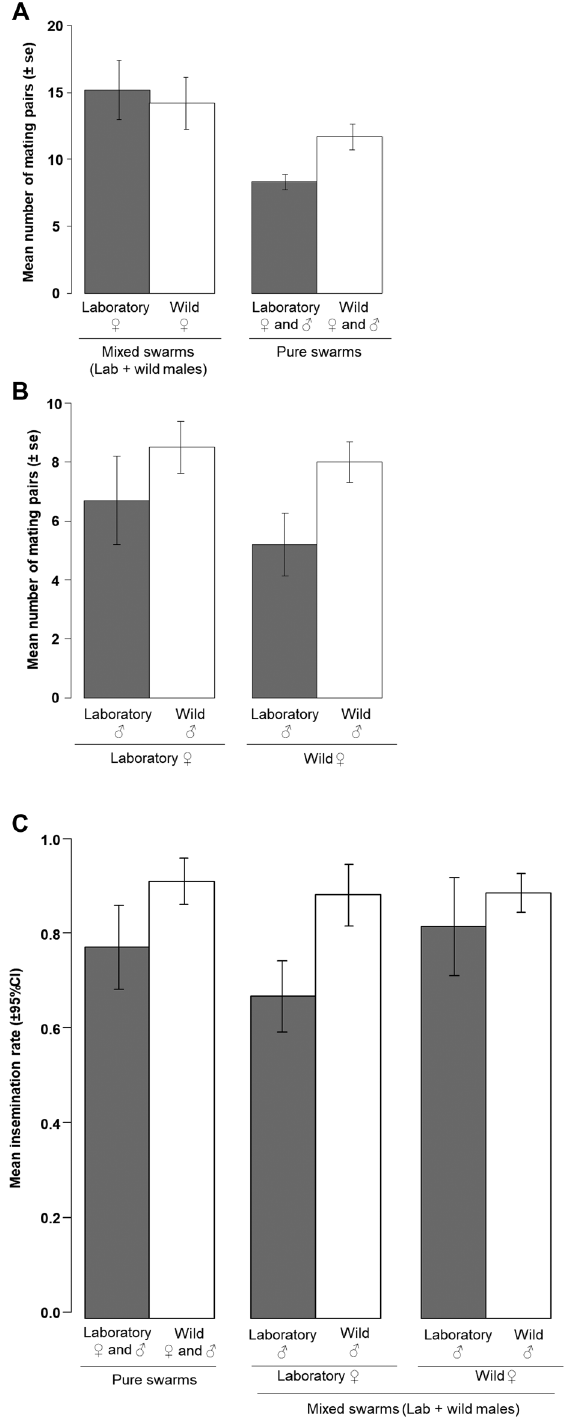
Figure 2. Effects of colonisation on male competitiveness (Experiment 2). ( A ) Mean number of mating pairs in both pure and mixed swarms of laboratory and wild males; ( B ) Observation of assortative mating through the mean number of mating pairs in mixed swarms with laboratory or wild females; ( C ) Mean insemination rate. CI: 95% confidence interval. SE: standard